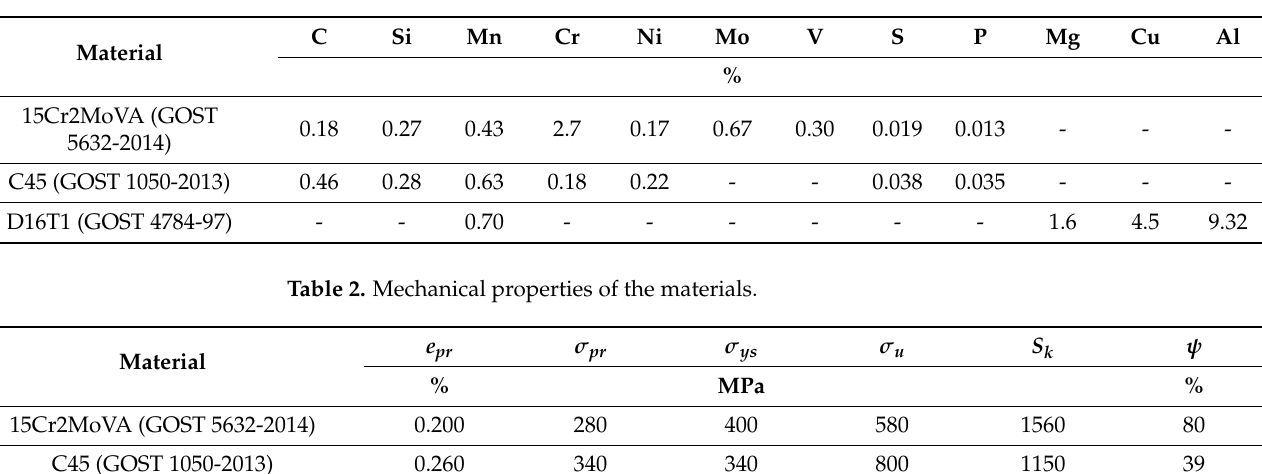
Table 1. The chemical composition of the materials.